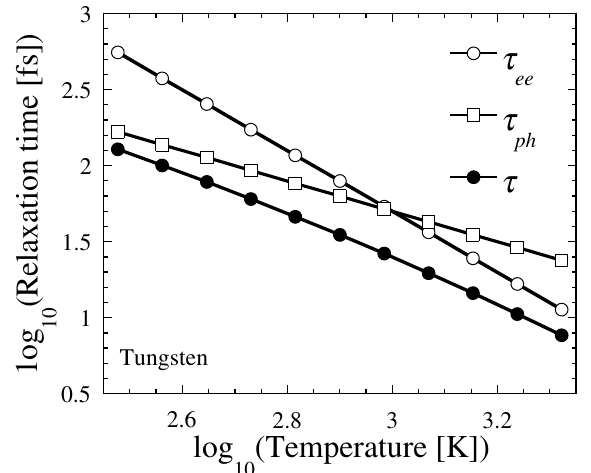
FIG. 1. Temperature dependence of the electron-electron and electron-phonon relaxation times, as per Eq. (6). The total relaxation time / is obtained via Matthiessen’s